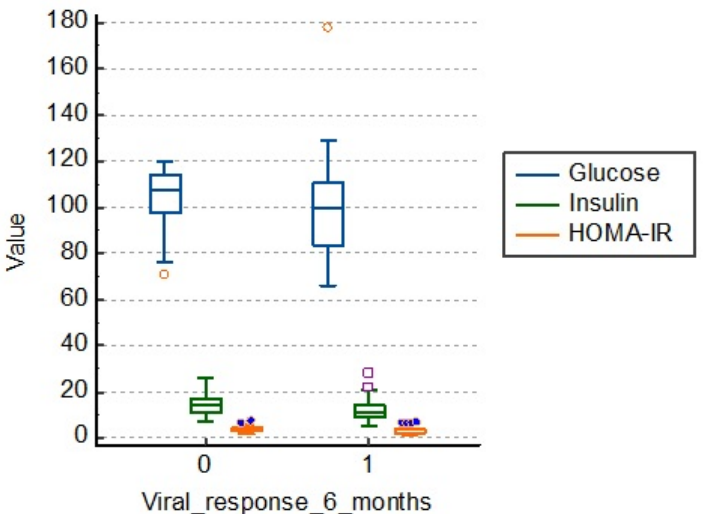
Figure 4. Distribution of the lot in relation to carbohydrate metabolism. HOMA-IR: homeostasis model of insulin resistance.